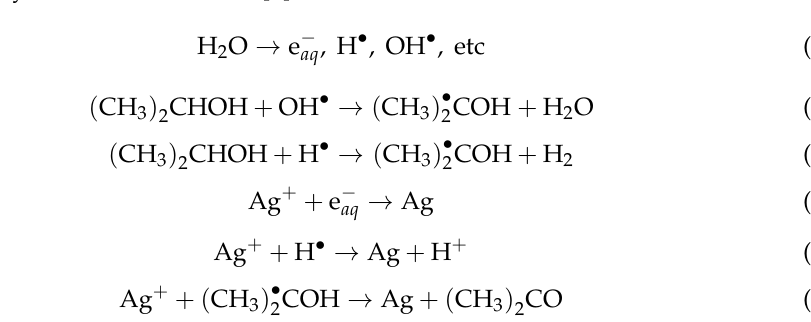
Table 5. Antiviral activity of Ag/ABS samples prepared by gamma ray against SARS-CoV-2. Common Logarithm of Samples Infectivity Titer Value (PFU/cm 2 ) * 1 Immediately after inoculation 5.65 ABS (Control) After 24 h 4.82 Ag/ABS (Gamma ray, After 24 h without 2-prop.)